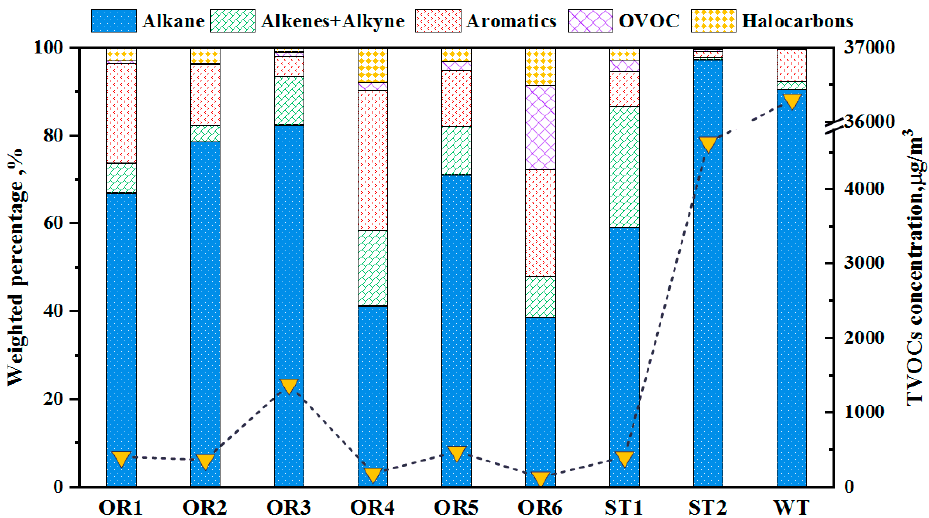
Figure 2. Overall chemical group patterns of VOC emissions from each petroleum unit. (Note: OR1: CDU&VDU; OR2: reforming hydrogenation; OR3: catalytic cracking; OR4: catalytic hydrogenation with wax oil; OR5: catalytic hydrogenation with gasoline and diesel; OR6: delayed coking; ST1: olefins tank; ST2: gasoline tank; WT: wastewater treatment).